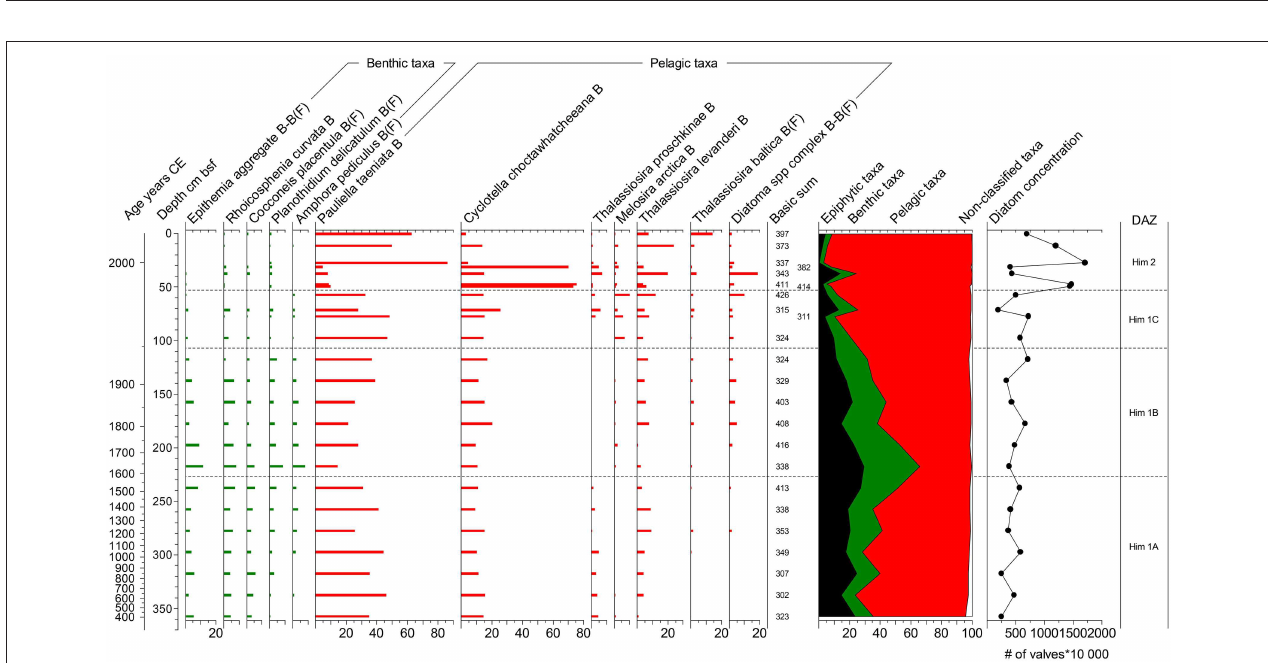
FIGURE 6 | Diatom diagram for the site Himmerfjärden. For details see legend to Figure 5 .